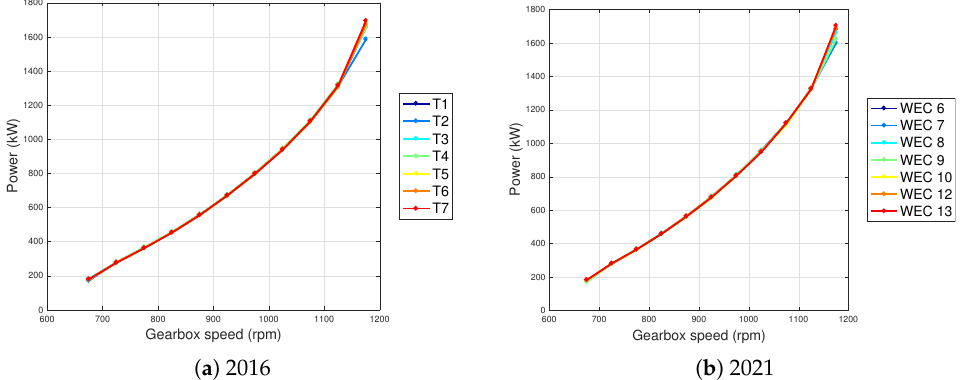
Figure 11. Gearbox speed–power curve for the whole wind farm, computed using the binning method.